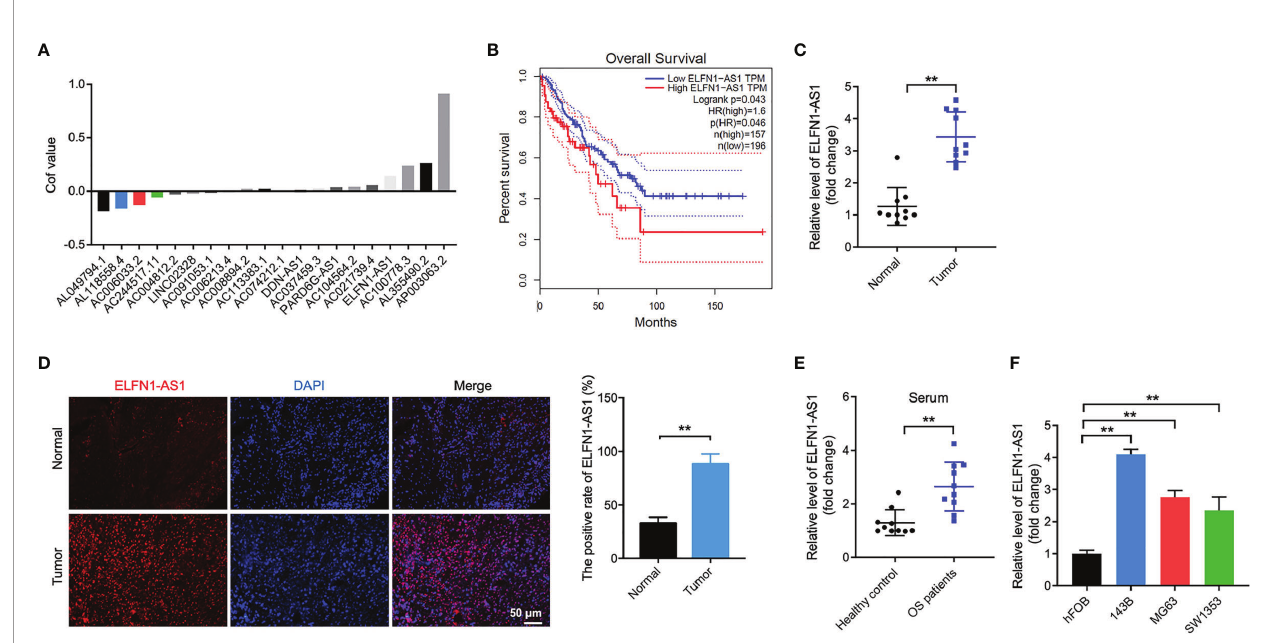
FIGURE 1 | ELFN1-AS1 levels are elevated in OS tissues and OS cells. (A) In the TARGET dataset, 8 downregulated DElncRNAs, and 12 upregulated DElncRNAs from OS tissues and corresponding normal controls were identi fi ed using LASSO Cox regression analysis. Volcano plot of DElncRNAs in TARGET dataset. (B) The correlation between the level of ELFN1-AS1 and overall survival rate of patients with OS in the TCGA dataset. (C) ELFN1-AS1 level in OS tissues and matched normal sample tissues were measured using RT-qPCR (n = 10). The data were statistically analyzed using Student ’ s t-test. (D) FISH staining analysis of ELFN1-AS1 level in OS tissues and matched normal tissues. (E) ELFN1-AS1 level in serum samples from patients with OS and healthy controls were measured using RT-qPCR (n = 10). The data were statistically analyzed using Student ’ s t-test. (F) RT-qPCR analysis of ELFN1-AS1 level in MG63 and SW1353 cells (n = 3). The signi fi cance between groups was analyzed by one-way ANOVA. **P <